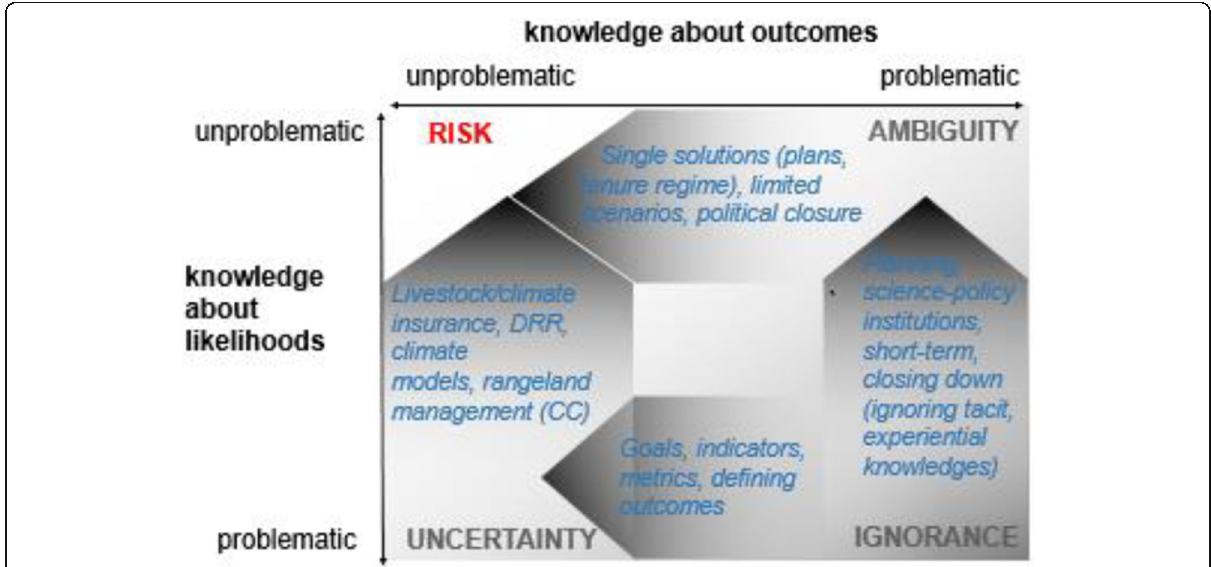
Fig. 2 Closing down: Institutions, practices, politics and power (adapted from Stirling